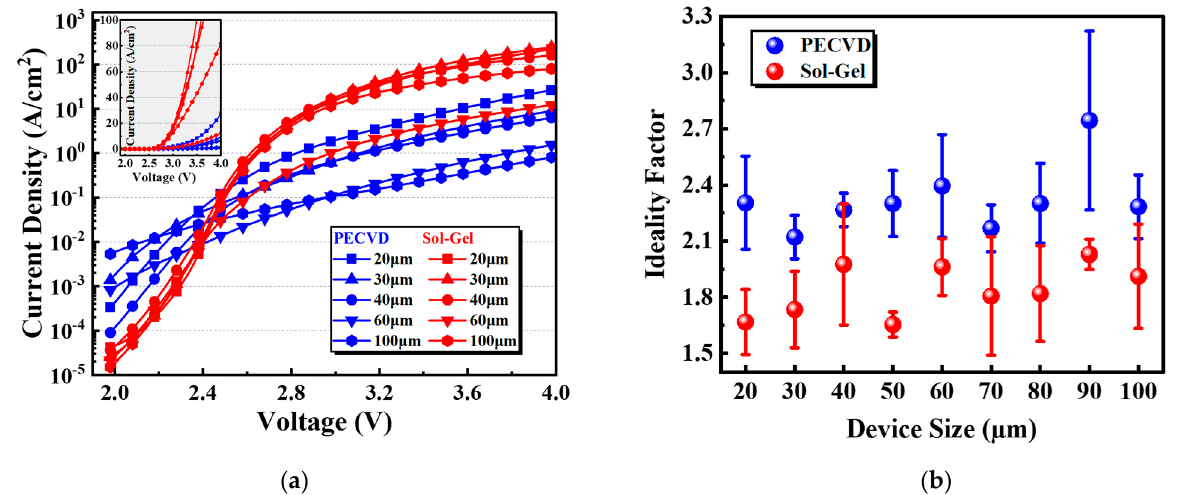
Figure 4. ( a ) Current density vs. voltage (J–V) characteristics of S2 and S3 for different sizes in log scale and linear scale; ( b ) ideality factor of S2, and S3 with different sizes.